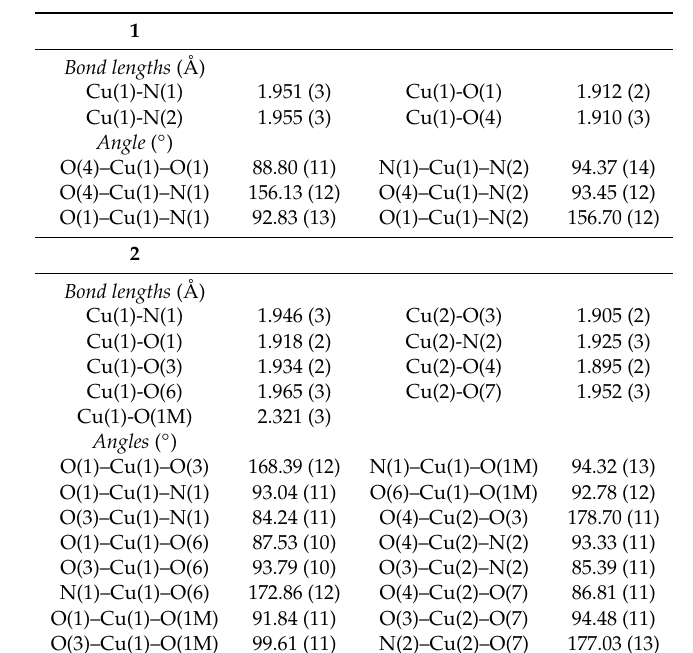
Figure 10. Part of the crystal structure of complex 4 showing the O–H ··· O hydrogen bonds and the formation of a three-dimensional supramolecular network. Table 2. Selected geometric parameters for the copper(II) complexes